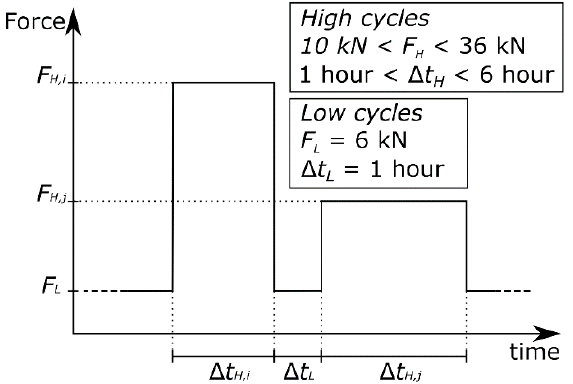
Figure 3. Definition of the loading procedure for the cyclically loaded beams.